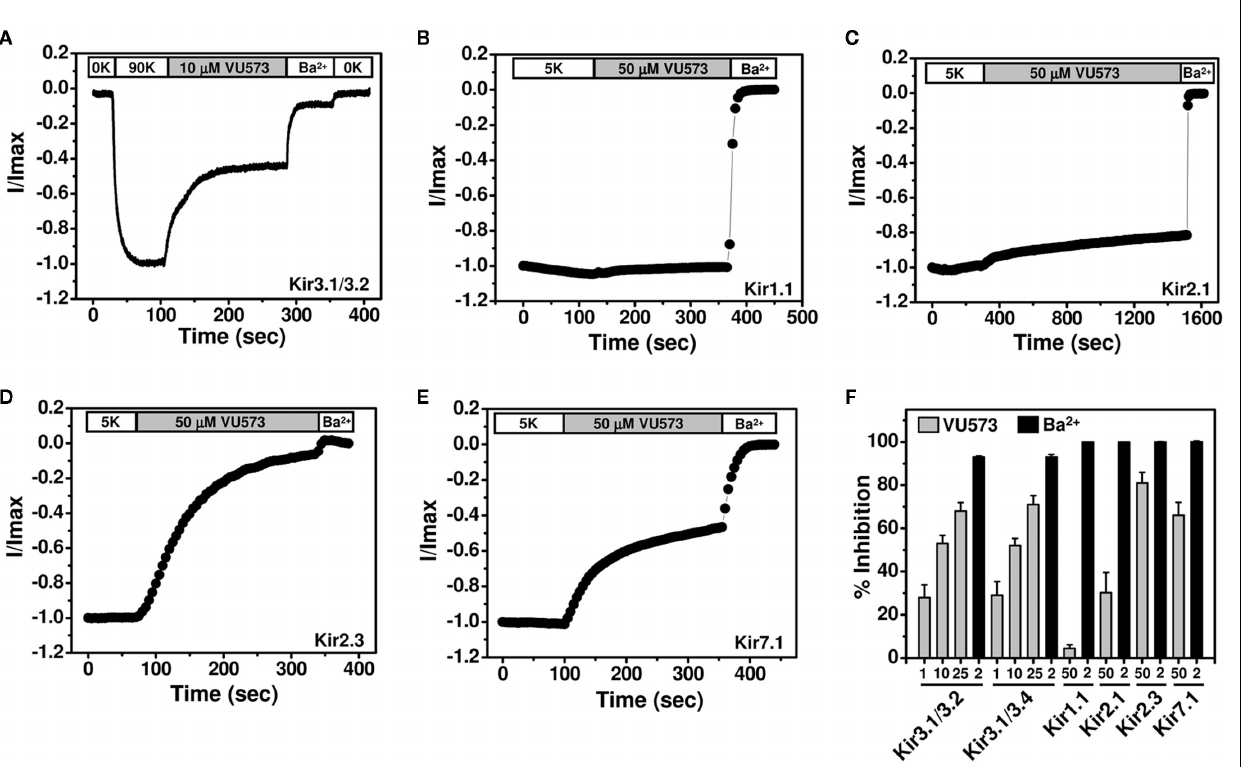
FIGURE 2 | Effect ofVU573 on Kir channels expressed in oocytes. (A) Representative Kir3.1/3.2 current traces recorded from an oocyte using the two-electrode voltage-clamp technique. Oocytes were initially bathed in a potassium-free (0K) solution and then switched to one containing 90mM potassium (90K) to activate Kir3.1/3.2. After reaching a steady-state, the oocyte was exposed to 10 μ MVU573 (in 90K) bath to inhibit Kir3.1/3.2. Residual Kir3.1/3.2 currents were inhibited with 2mM barium (Ba 2 + ). A final